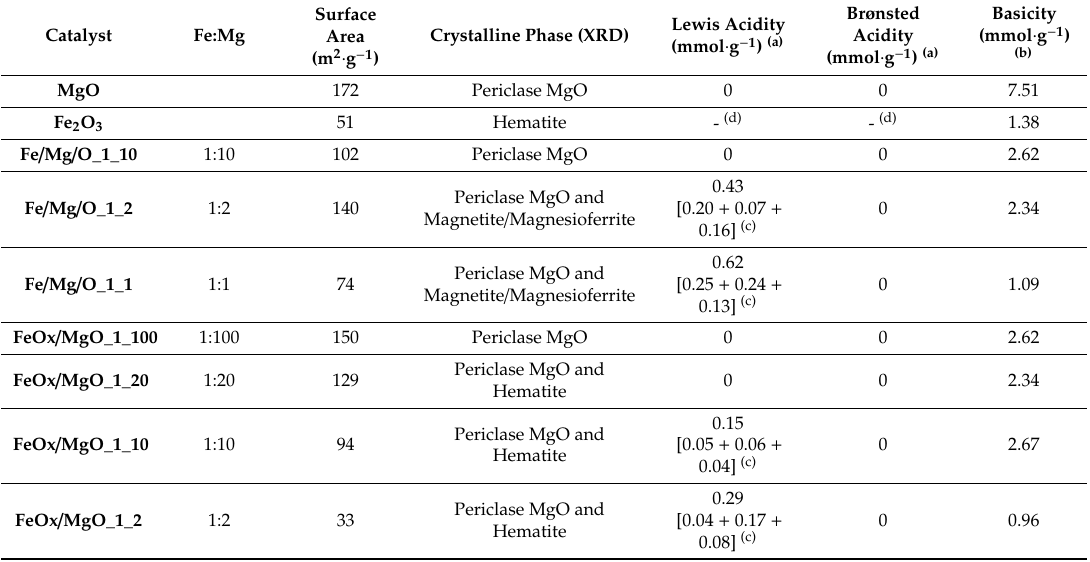
Table 1. Physicochemical properties (specific surface area, crystalline phase, Lewis acidity, Brønsted acidity and basicity) of MgO, Fe 2 O 3 and Fe / Mg / O coprecipitated and synthesized by incipient wetness impregnation